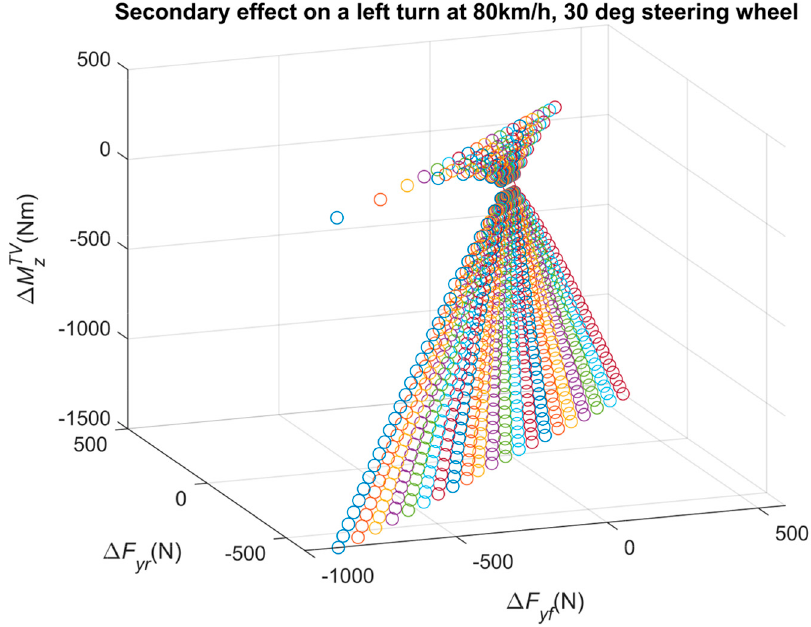
Figure 3. Changes in the lateral force for different yaw torque requests and distributions.